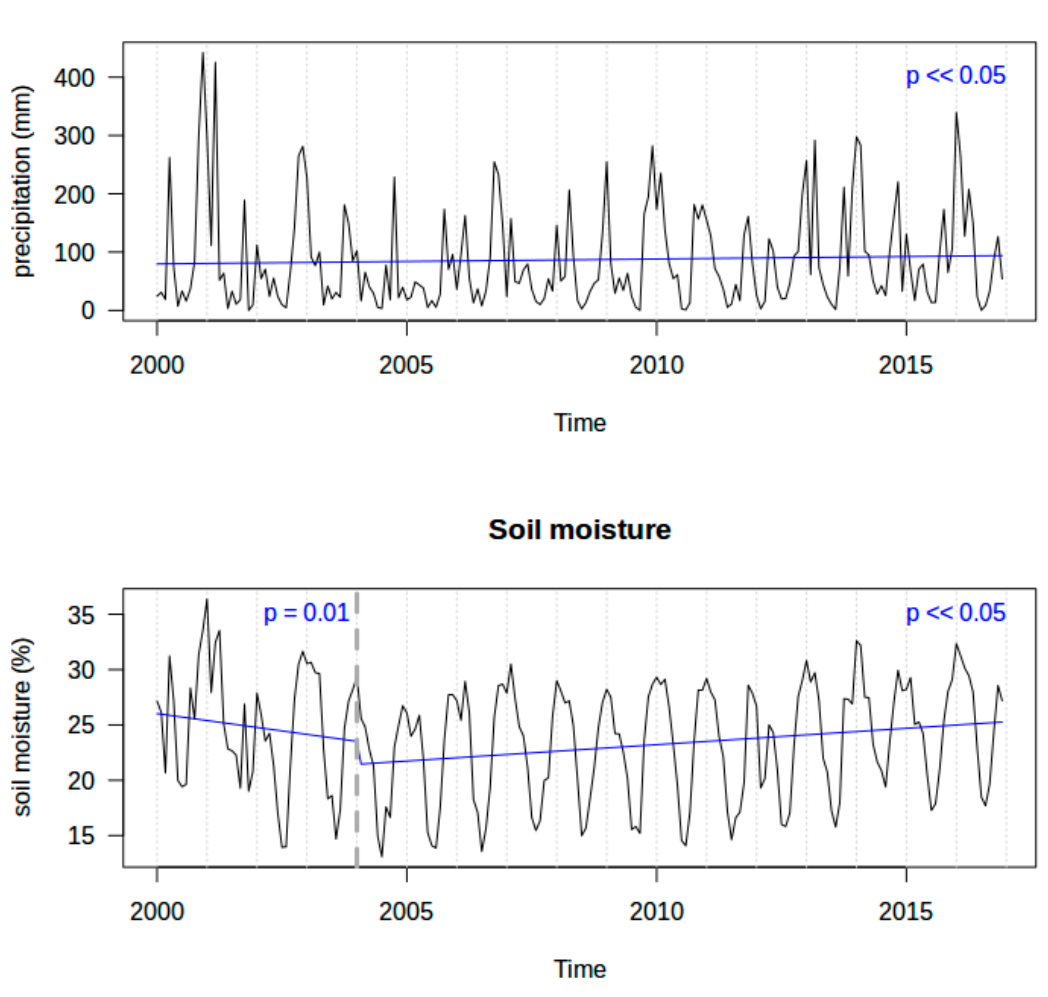
Figure 5. Trend in ESA CCI SM [28] and precipitation from E-OBS [35] for the period 2000–2016 in PGNP.